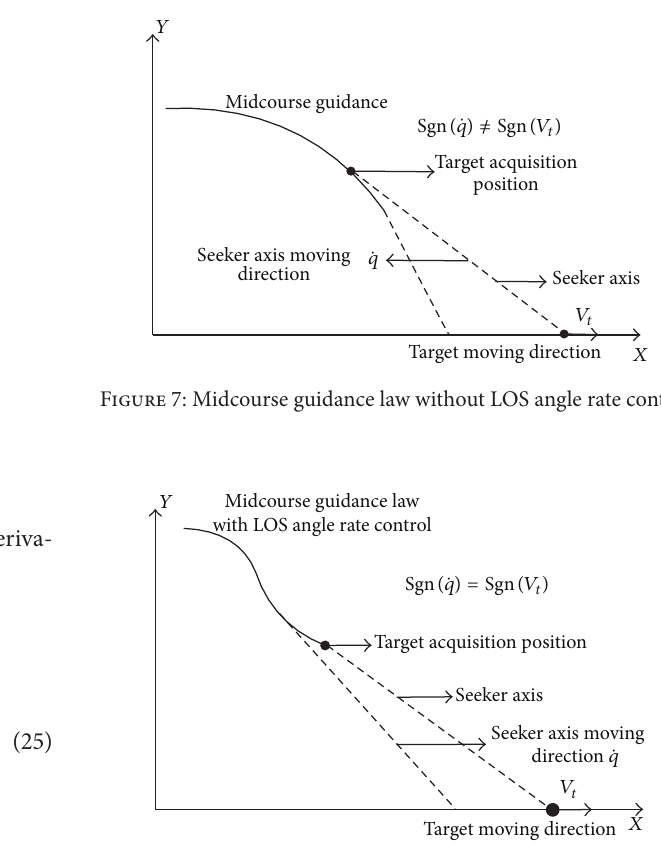
Figure 8: Midcourse guidance law with LOS angle rate